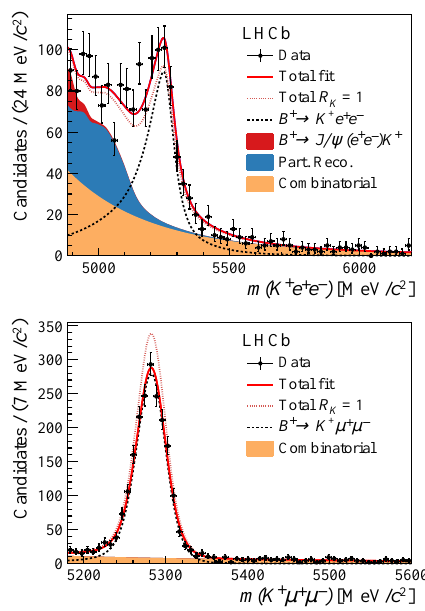
Figure 1: Fits to the m ( K + (cid:96)(cid:96) ) invariant mass distributions for (up) electron and (down) muon candidates for nonresonant decays. The red-dotted lines show the distributions that would be expected from the observed number of B + → K + (cid:96)(cid:96) decays and R K = 1.